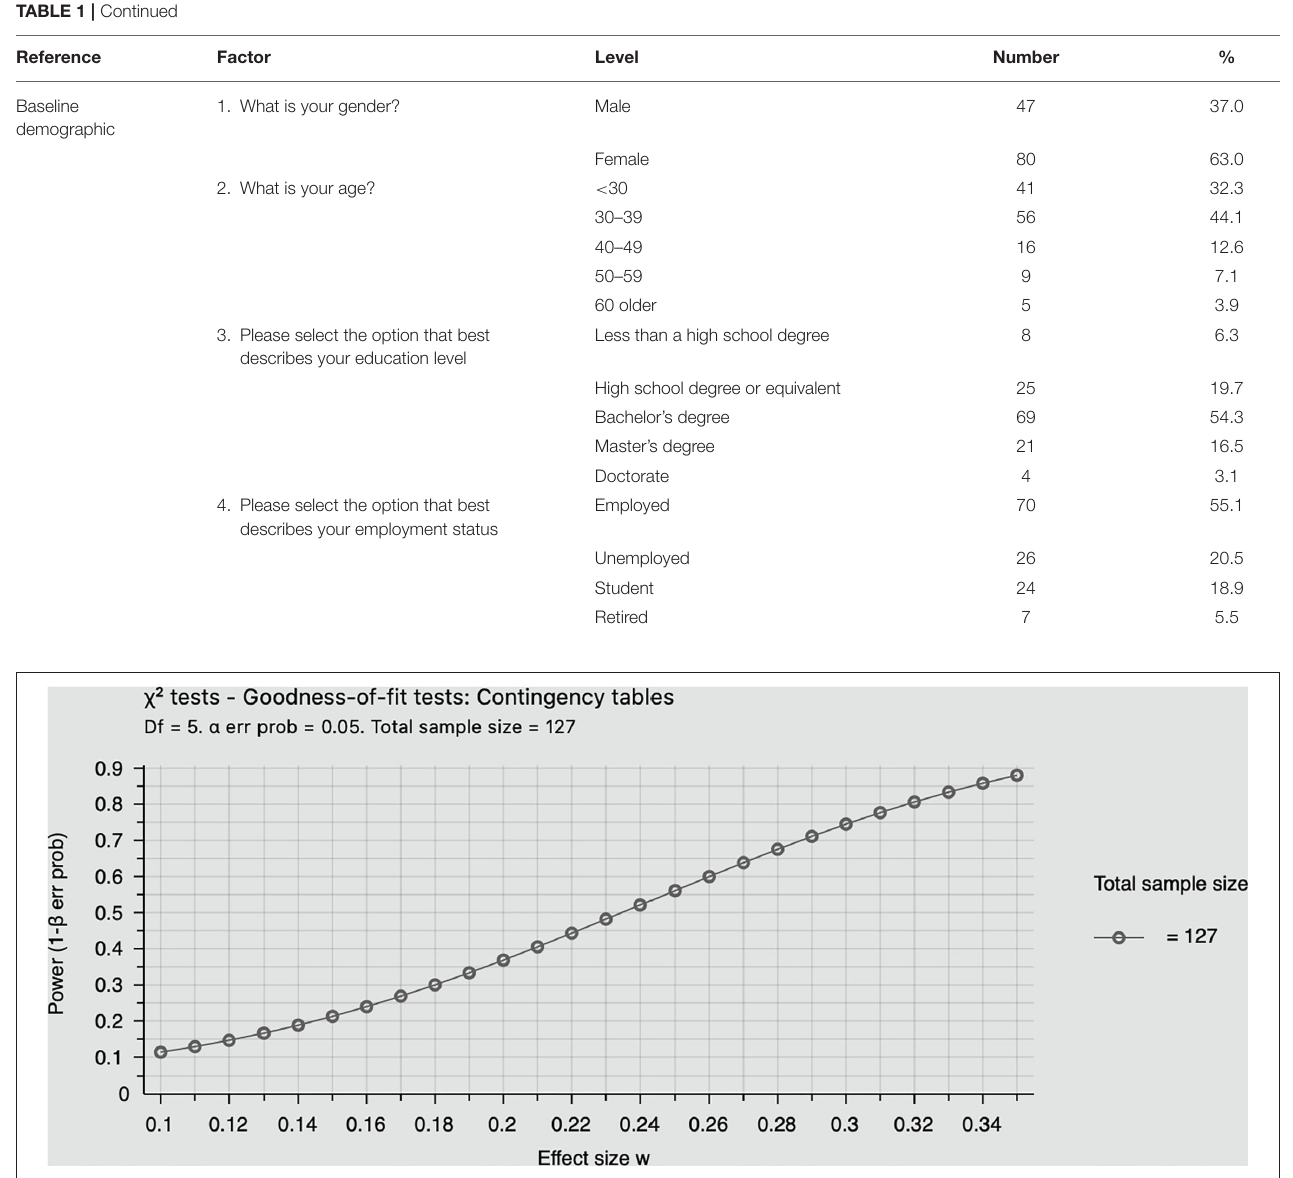
FIGURE 1 | Post-hoc analysis showed the power in relation to total sample size.